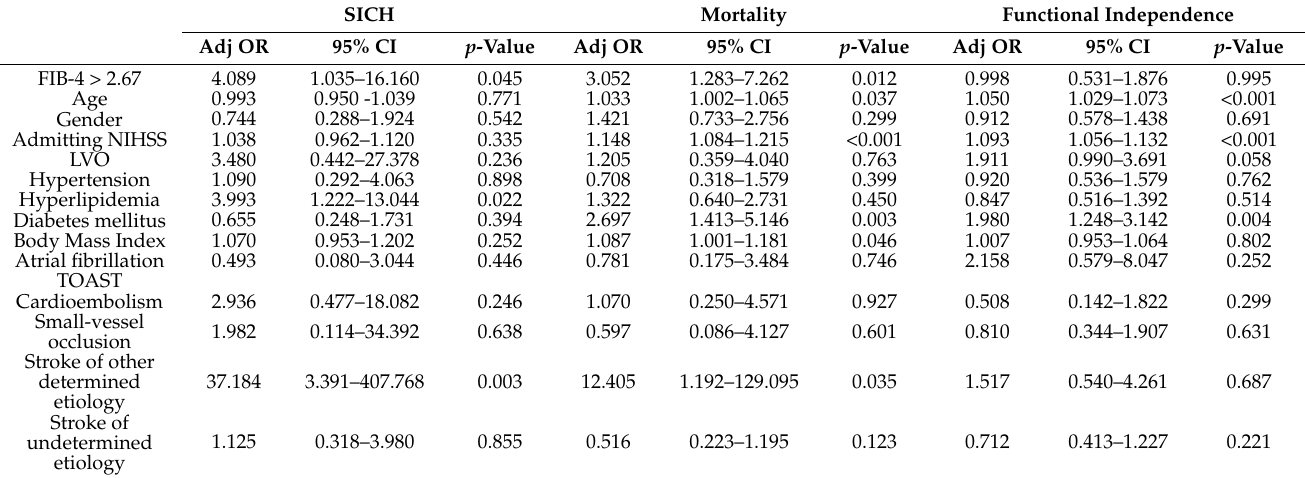
Table 2. Predictors for Symptomatic Intracranial Hemorrhage using Multivariable Logistic Regression. SICH